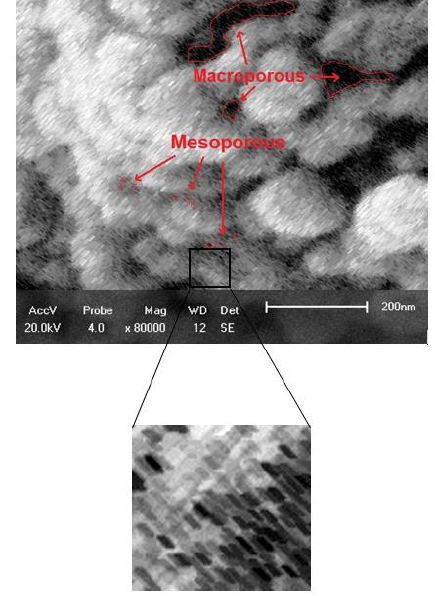
Figure 3. Mesopore and macropore ordering in the bimodal silica.